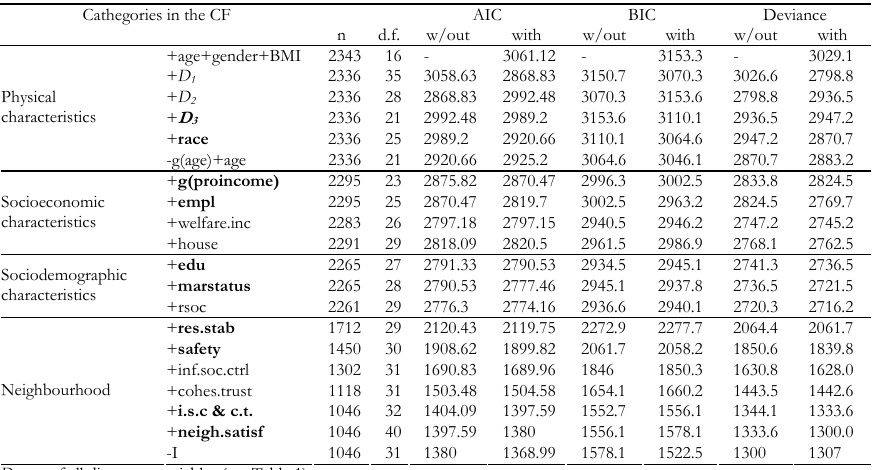
Pairwise comparisons of ZIP models for successive additions of variables from base model M 0 (including age, gender and BMI) to final model M 1 (including variables in bold face in the table) Cathegories in the CF AIC BIC Deviance n w/out with w/out with w/out with